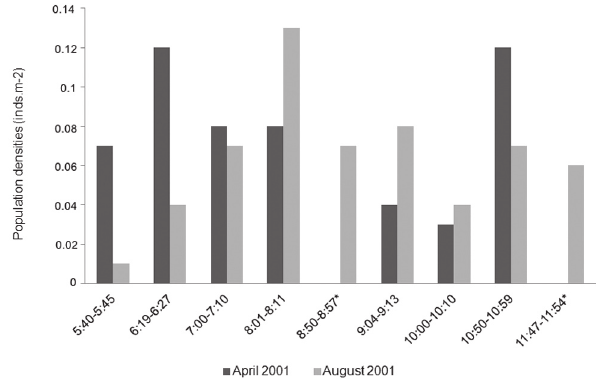
Fig. 6 . Population densities of Eigenmannia trilineata from rio da Lapa, São Domingos karst area, central Brazil, observed from dusk until night phase during two nights (April and August 2001). Asterisk indicates that no sample was recorded in this period at April 2001.